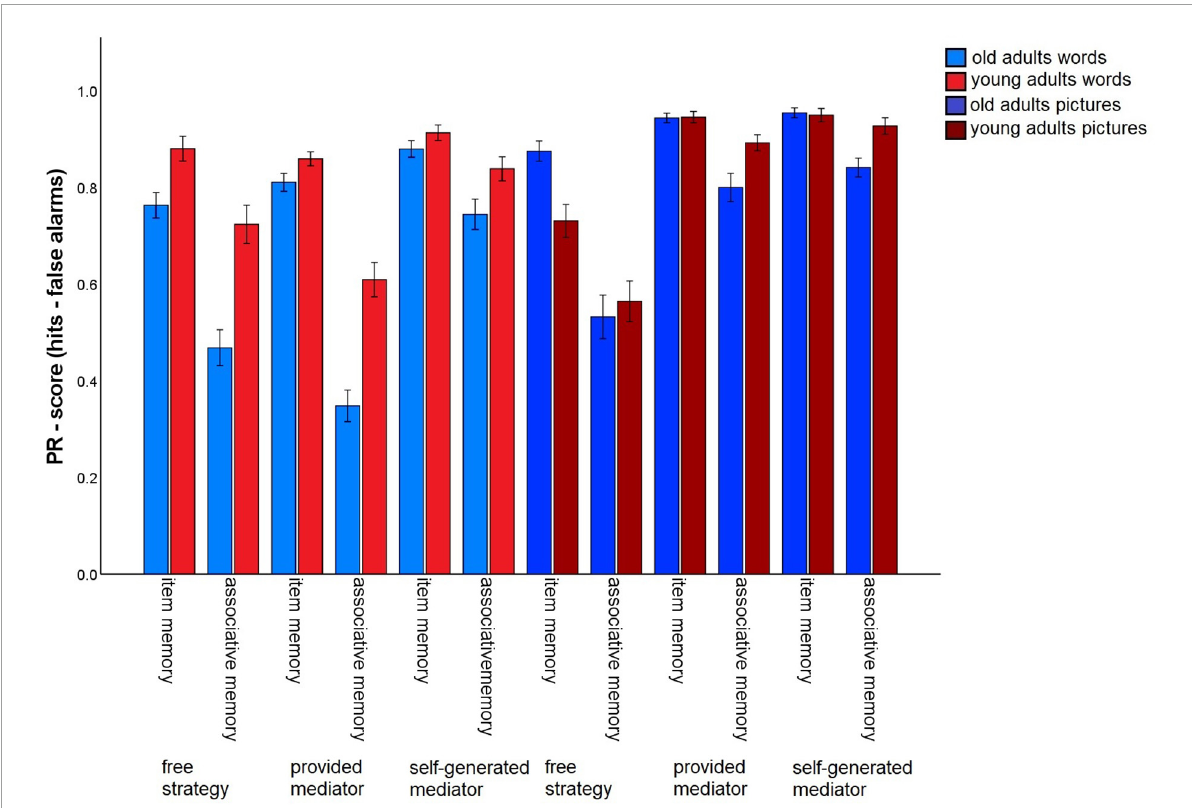
FIGURE4 Pr-Scores of item memory and associative memory for words and pictures, separated for young and older subjects and for the three different levels of guidance. Task 3 is the free strategy selection task of the first session. Task 4: Sentence generation task with provided mediators, task 6: sentence generation task with self-generated mediators, task 5: interactive imagery task with provided mediators, task 7: interactive imagery task with self-generated mediators. Error bars represents the standard of the error